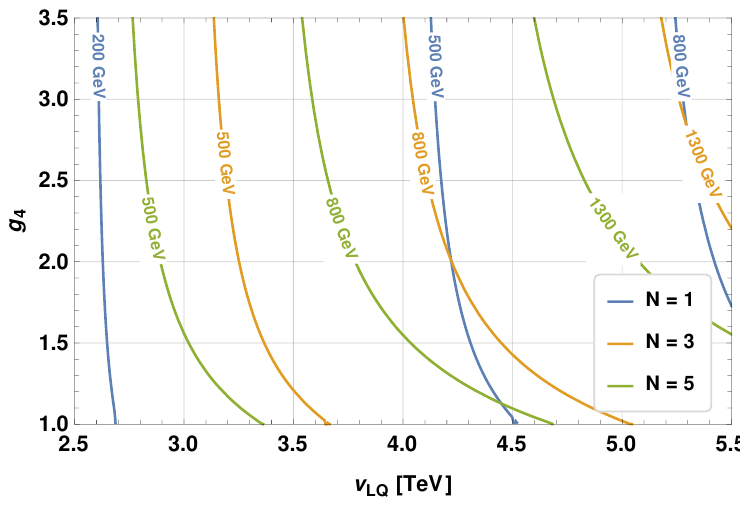
Figure 6 . The (cid:10) 0 h 2 in the v LQ vs. g 4 plane. Along the isolines, the (cid:10) 0 h 2 constraint is ful(cid:12)lled for the value of M (cid:31) speci(cid:12)ed along the line itself.